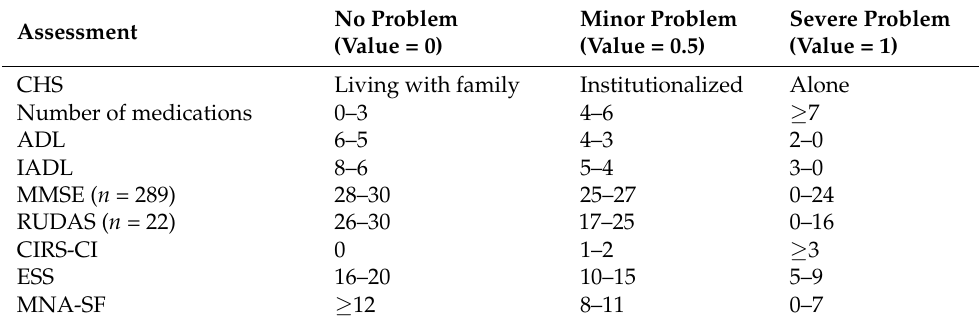
Table 1. MPI risk score is assigned to each domain based on the severity of the